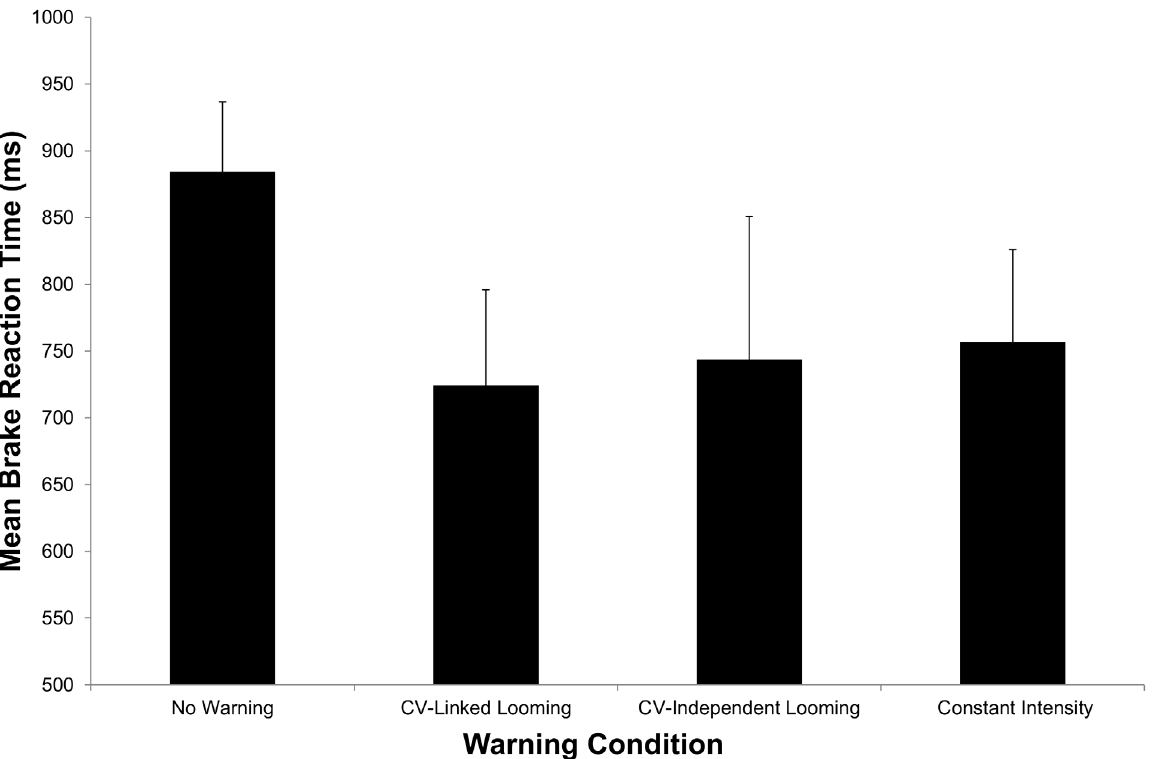
Figure 1. Mean braking reaction times for Experiment 1. Error bars are standard deviations.